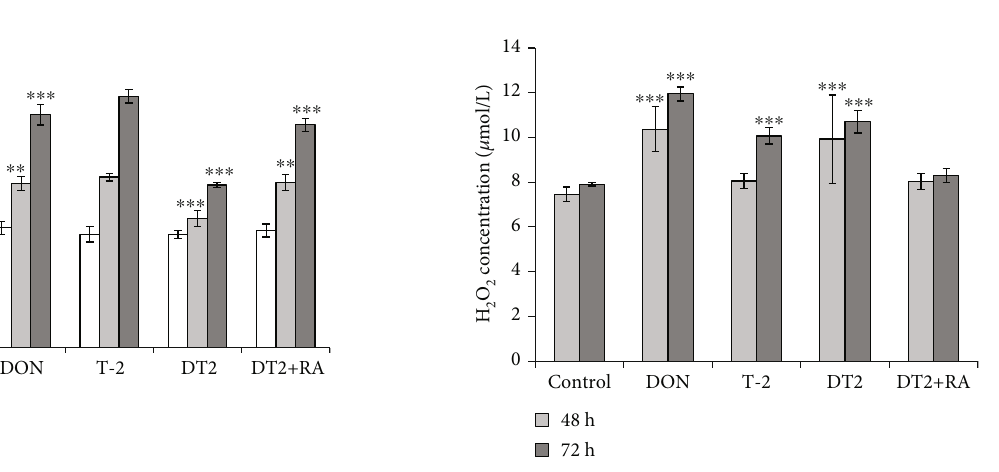
Figure 3: Transepithelial electrical resistance (TEER) measurements of IPEC-J2 monolayers. Cells were incubated with 1 μ mol/L DON, with 5nmol/L T-2, with DT2 ( 1 μ mol/L DON + 5nmol/LT − 2 ), and with DT2 + RA ( 1 μ mol/LDON + 5nmol/LT − 2 + 50 μ mol/L RA ) (24h preincubation) for 48h and 72h. TEER values are expressed in k Ω × cm 2 . ∗∗ p < 0 : 01 and ∗∗∗ p < 0 : 001 compared to the control values. Data are presented as TEER means ± SDs ( n = 9 ).